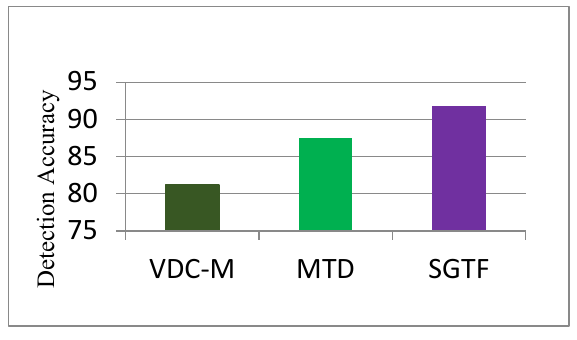
Figure.6. Performance comparison of